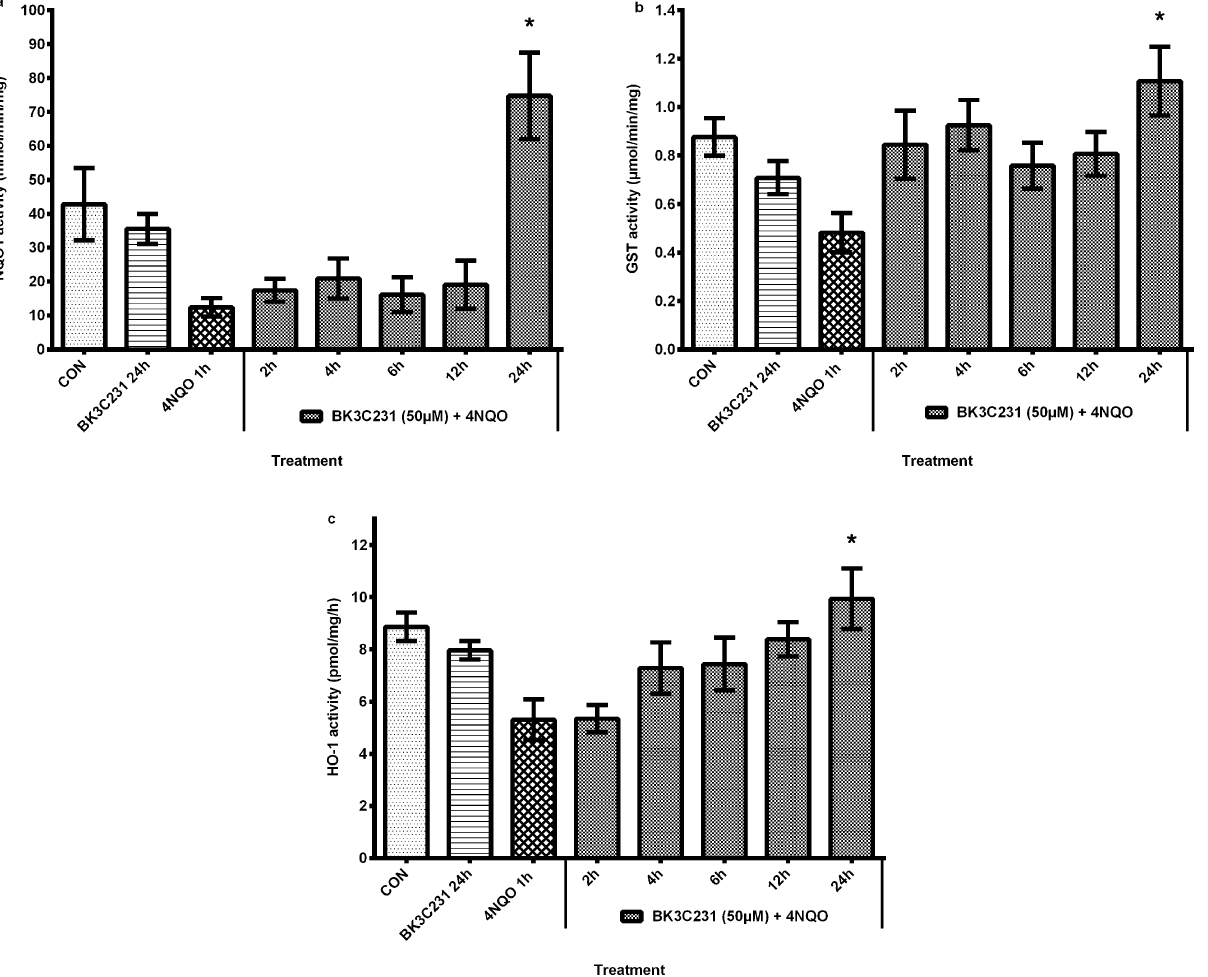
Figure 1. Effect of BK3C231 pretreatment on the activity of cytoprotective enzymes namely NQO1 ( a ), GST ( b ), and HO-1 ( c ). The enzymatic activity of cytoprotective enzymes was observed at basal level in untreated control cells (CON) and cells treated only with BK3C231 (BK3C231 24 h). However, in cells treated only with 4NQO (4NQO 1 h), there was a decrease in the activity of cytoprotective enzymes as compared to that of untreated control cells. Pretreatment of cells with BK3C231 before 4NQO exposure increased the activity of cytoprotective enzymes, significantly at 24 h as compared to that of cells treated with 4NQO only. Treated whole cell lysates were subjected to spectrophotometric and microplate reader data analysis as mentioned in “Results” to determine the activity of NQO1, GST and HO-1. Each data point was expressed as mean ± SEM from at least three independent experimental replicates. * p < 0.05 against 4NQO 1